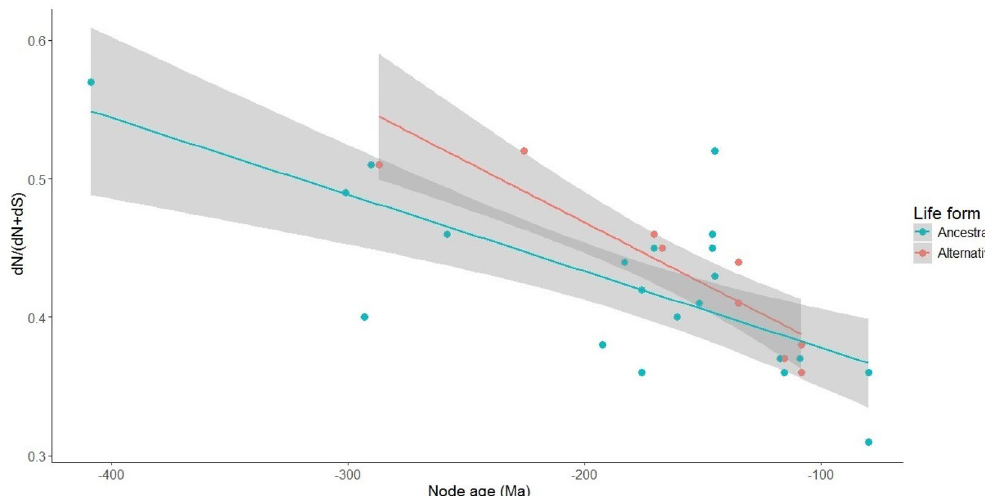
Figure 2. Scatter plots and regression lines displaying the number of nonsynonymous mutations as a proportion of the total number of mutations (i.e. dN/(dN + dS)) as a function of time (i.e. branch length/node age (Ma)). The blue dots represent the proportion of nonsynonymous mutations for taxa with the ancestral state (R 2 = 0.52), while the red dots represent the taxa that illustrate life form shifts (i.e. the alternative state) (R 2 = 0.82). The shaded regions represent the 95% confidence intervals of the regression